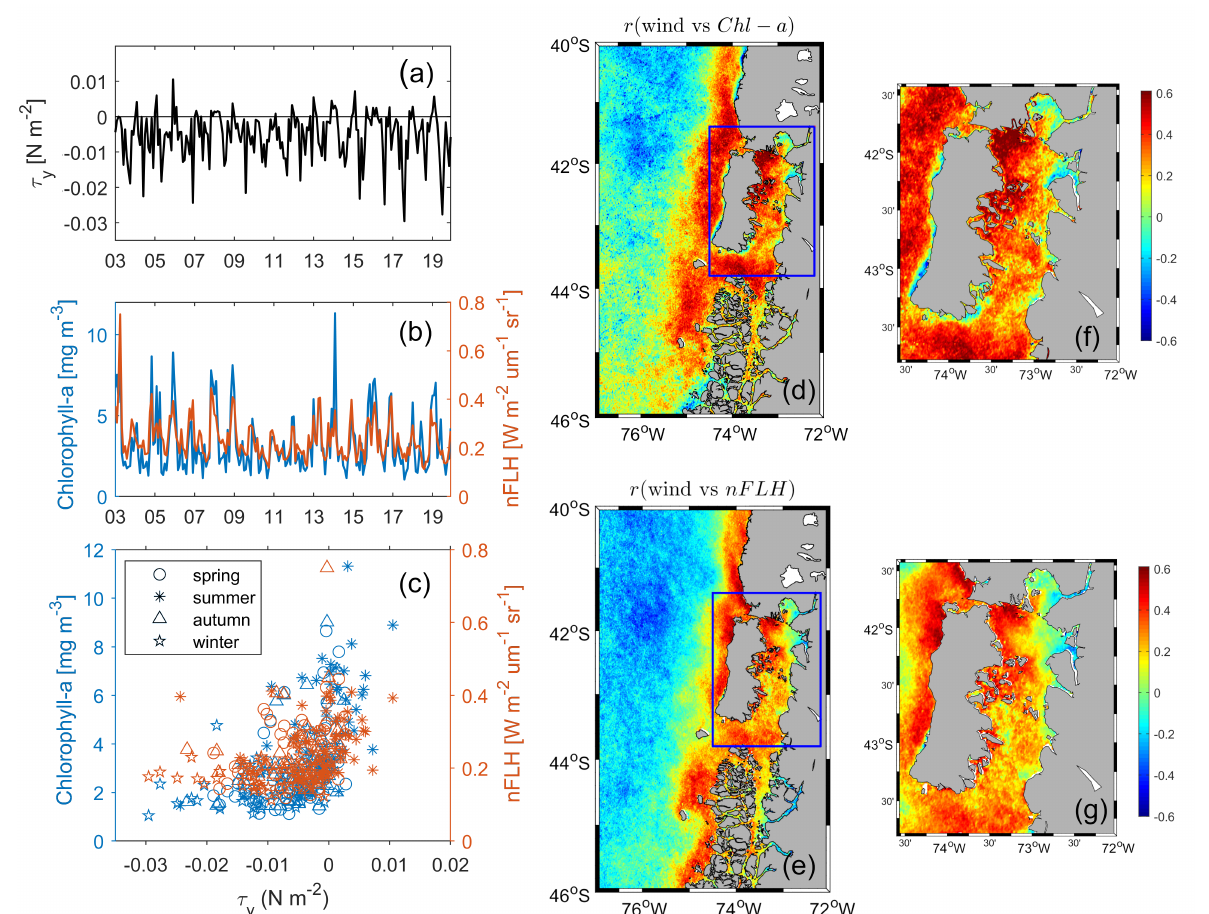
Figure 6. Time series of mean ( a ) meridional wind stress and ( b ) Chl-a and nFLH at Boca del Guafo (region between 73 ◦ –74 ◦ W and 43 ◦ –44 ◦ S). ( c ) Chl-a and nFLH concentration as function of meridional wind stress. Spatial fields of linear correlation coefficient between meridional wind stress at Boca del Guafo and Chl-a ( d – f ) and nFLH ( e – g ). The Inner Sea of Chiloé (ISC) is enclosed in a blue box and shown in ( f , g ) for better visualization. For reference of locations, see Figure